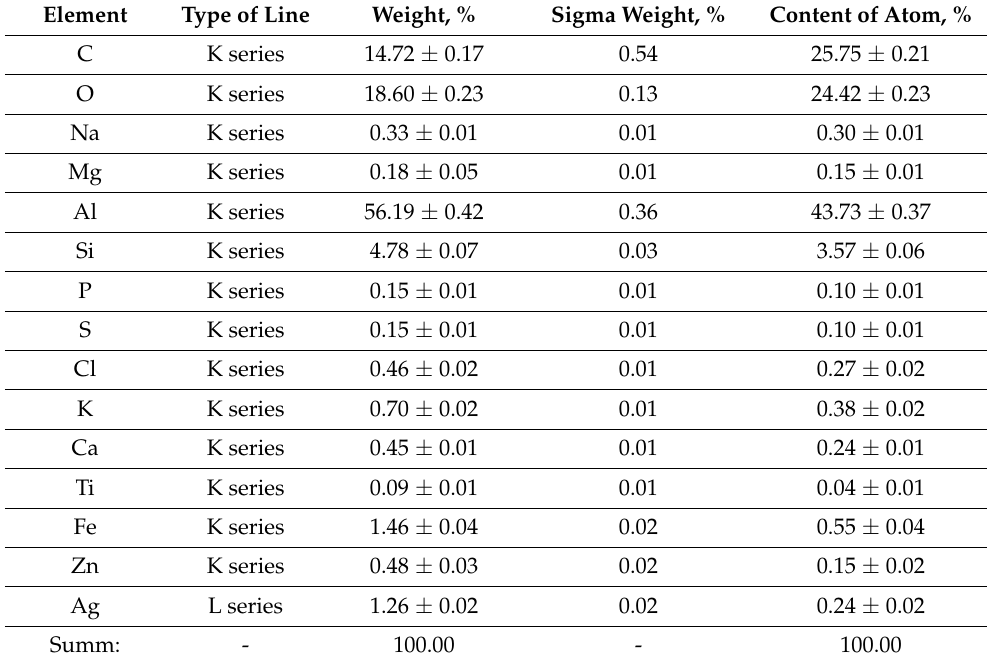
Table 2. Interpretation of the spectra of the elemental composition of an electrical aluminum alloy of the ABE wire